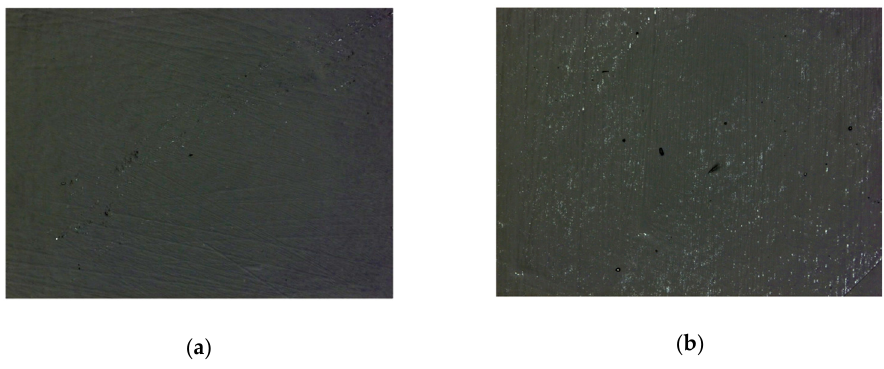
Figure 9. SEM diagrams at different molding pressure: ( a ) F = 210 N; ( b ) F = 250 N.